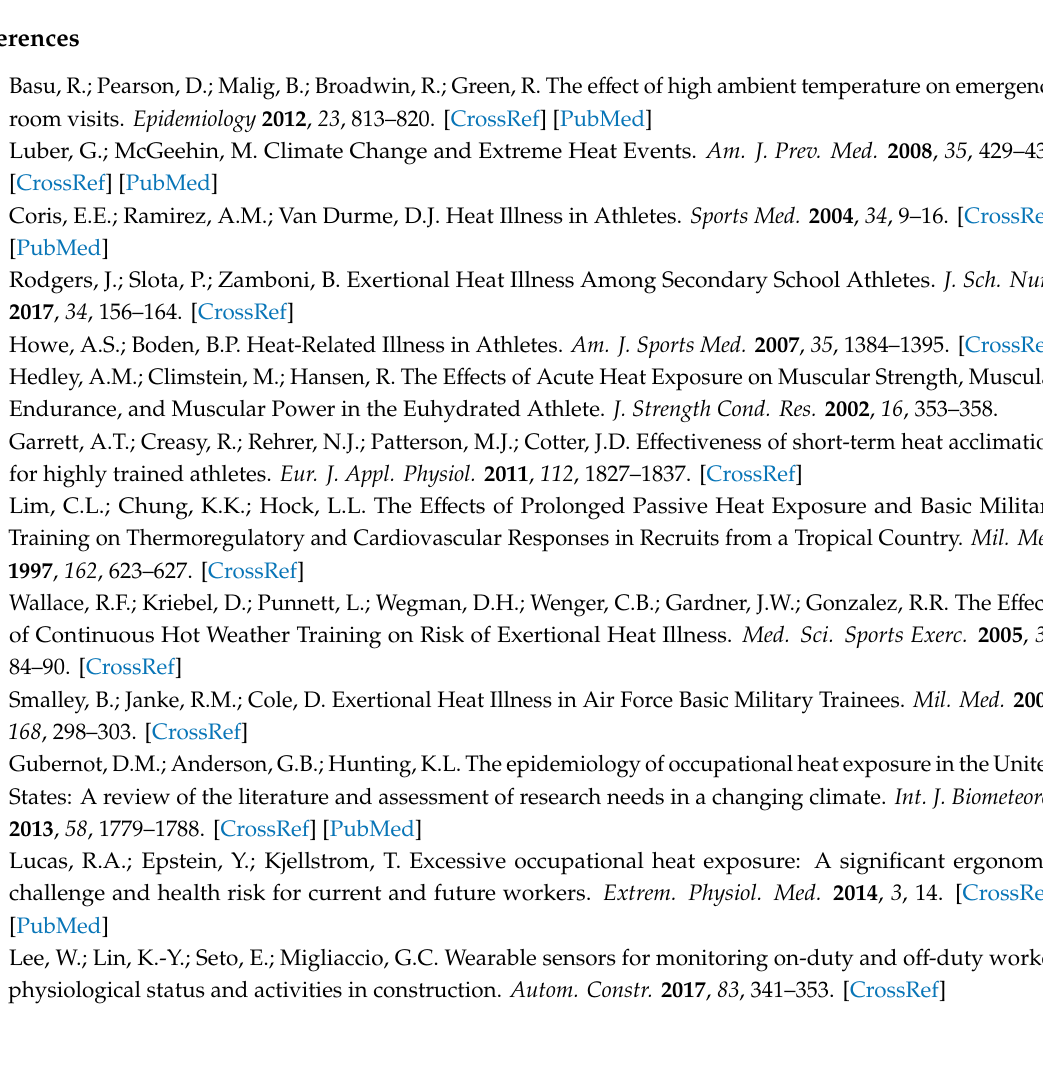
Figure S1: Schematics for the main board of device, Figure S2: Schematics for the peripheral board of